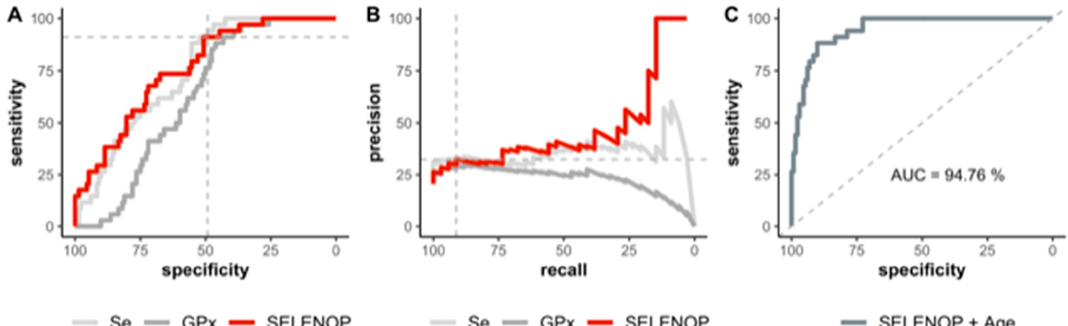
Figure 4. Receiver operating characteristics (ROC) analyses of Se status biomarkers in relation to risk of death from COVID-19. ( A ) ROC analyses as univariate prediction models based on the serum concentrations of SELENOP, Se, and GPx3 (pooled values from admission to the endpoint of the study) are capable of discriminating between patients that died and those that have been discharged. The optimal cutpoint of SELENOP concentrations at 3.1 mg / L according to Youden’s J statistics is indicated by the point where the dashed grey lines cross. ( B ) The corresponding precision recall curve (PRC) indicates the fraction of true positives among all the positive predictions and may serve as a meaningful addition to current risk estimates. The corresponding cutpoint is again indicated. ( C ) ROC analysis of SELENOP status in relation to risk of death from COVID-19 with respect to the patients’ age. The area under the curve (AUC) is indicated below the diagonal 50% line.